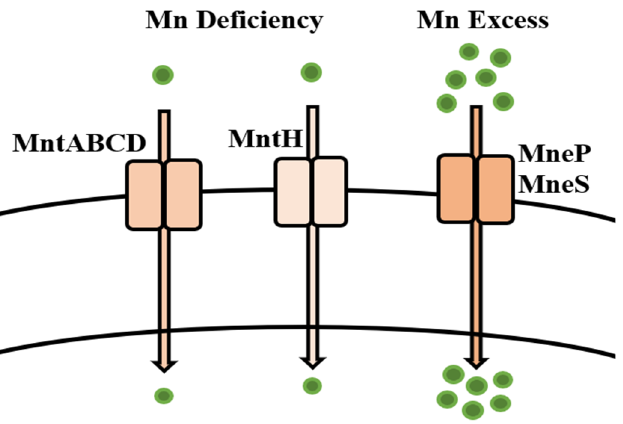
Figure 9. Uptake mechanisms of Bacillus spp. for the regulation of manganese inside bacterial cell.